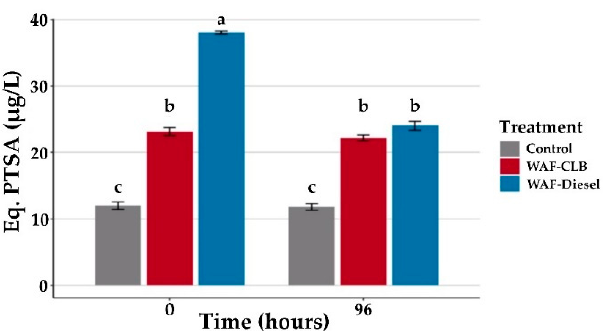
Figure 2. Hydrocarbon concentrations in each treatment (Control, WAF-CLB, and WAF-Diesel), measured by fluorescence (Cyclops-7) and expressed in PTSA equivalent ( µ g/L) before (0 h) and after 96 h of exposure. Series A and B are combined. Mean ± SE; n = 6. The letter symbols indicate a significant (p < 0.05) effect between time and treatment.